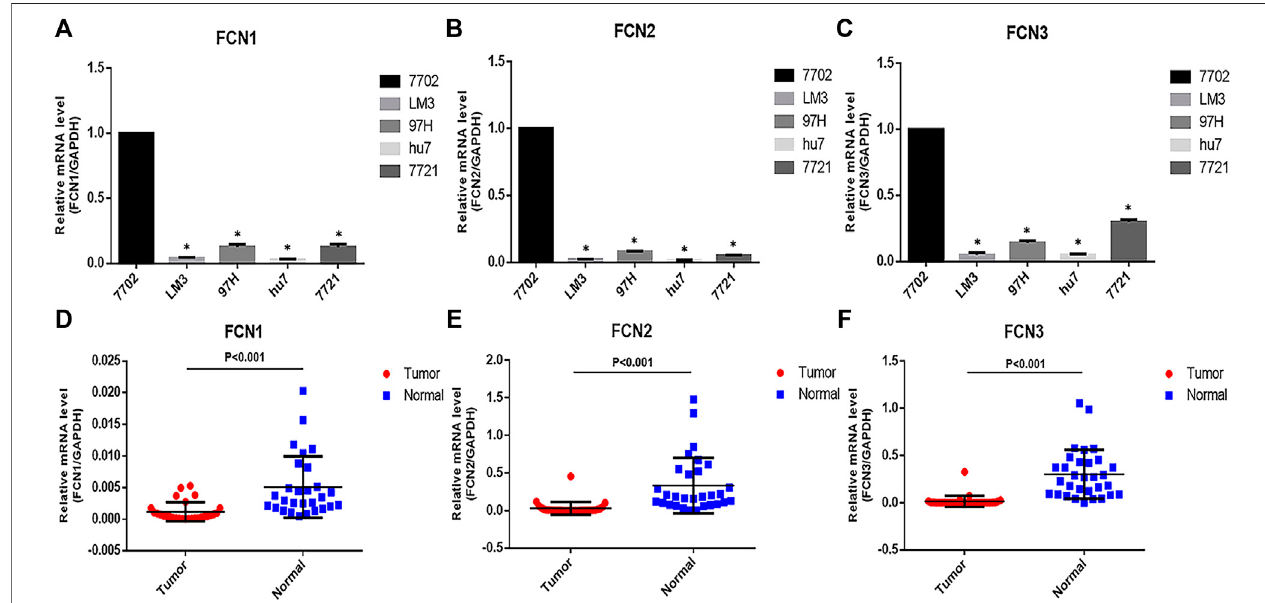
FIGURE 3 | The expressions of FCNswere down-regulated in LIHC cells and tissues. (A – C) . The mRNA expression of FCNsin 7,702, LM3, 97H, hu7, and 7,721 cell. (D – F) . mRNA expression of FCNs in LIHC tissues. * p < 0.05.